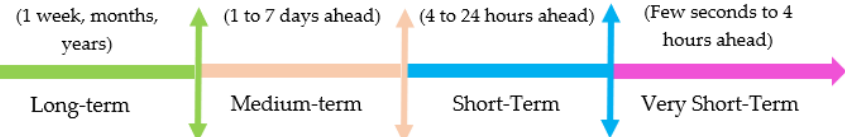
Figure 5. Wind-speed and -power forecasting taxonomy.